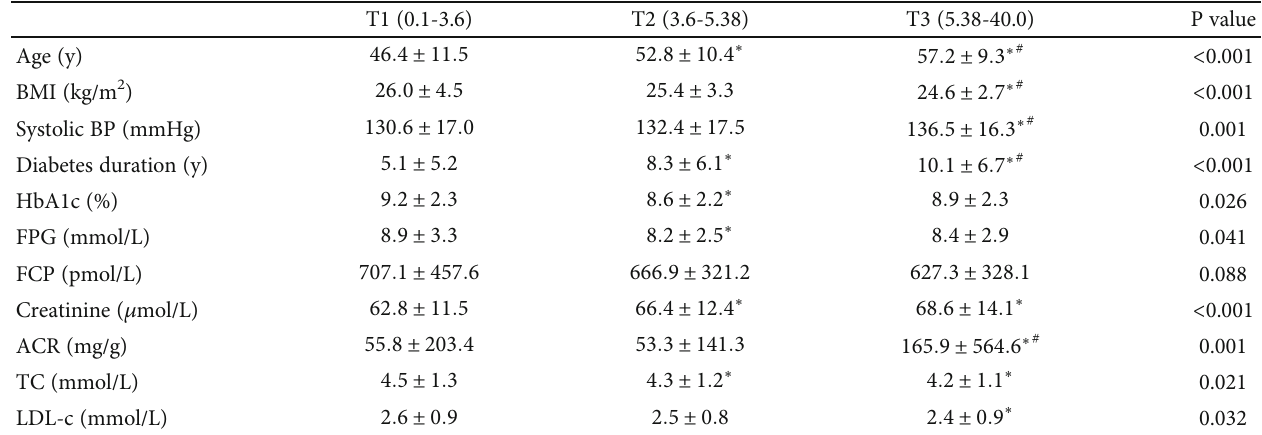
Table 4: Characteristics of male subjects by tertiles of